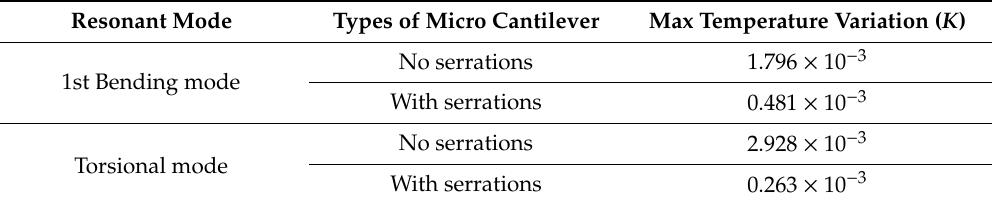
Table 4. Max Temperature variation ( K ) in slotted MCL and slotted MCL with edge